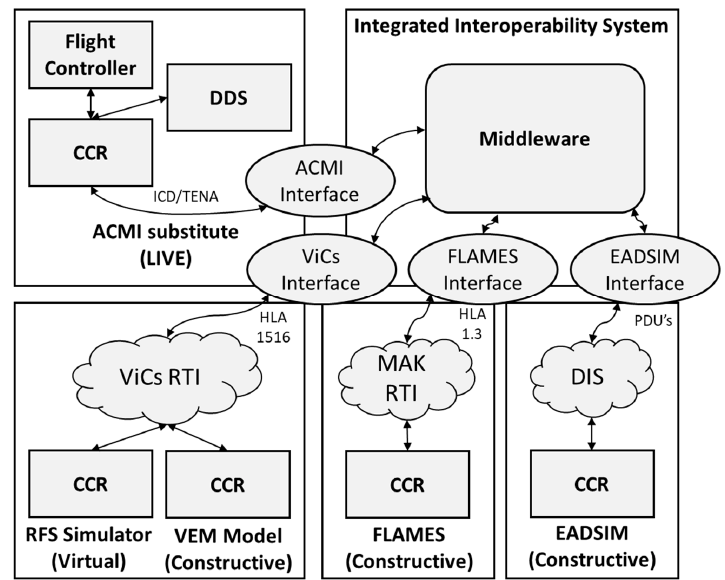
Figure 22. Interconnection view of the LVC system (adapted from [22]).